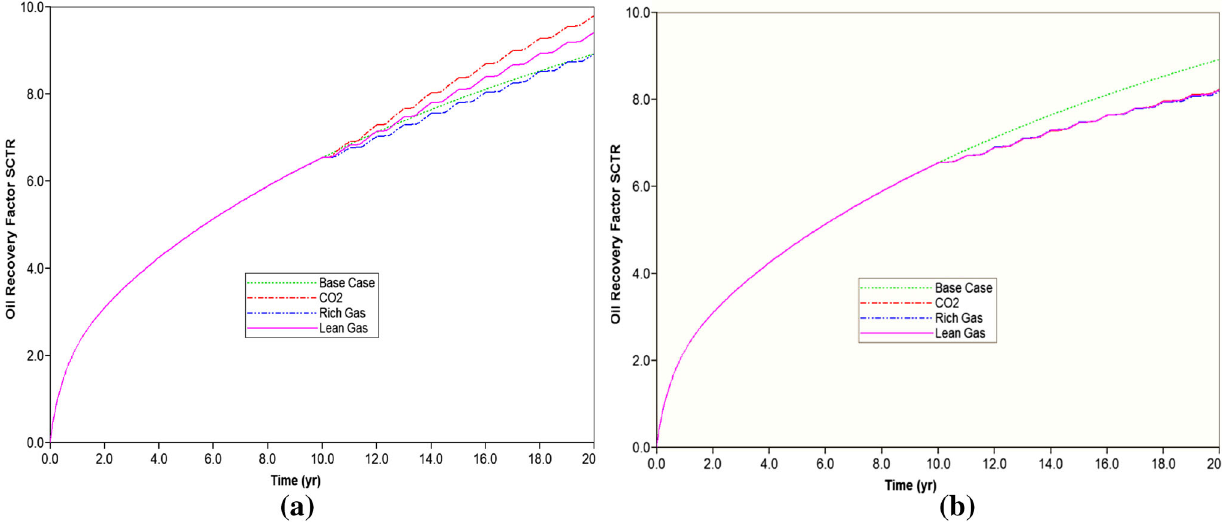
Fig. 10 Miscible gases performance in Bakken model for the 1st scenario. a Molar diffusion mechanism is ON. b Molar diffusion mechanism is